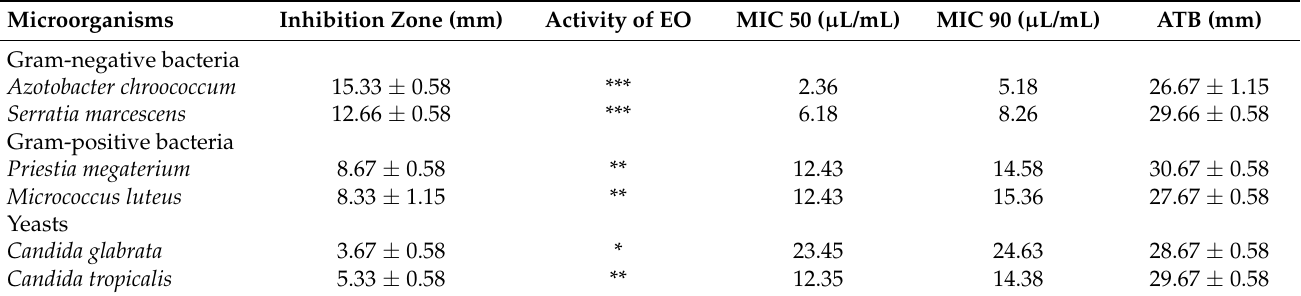
Table 2. Antimicrobial activity of